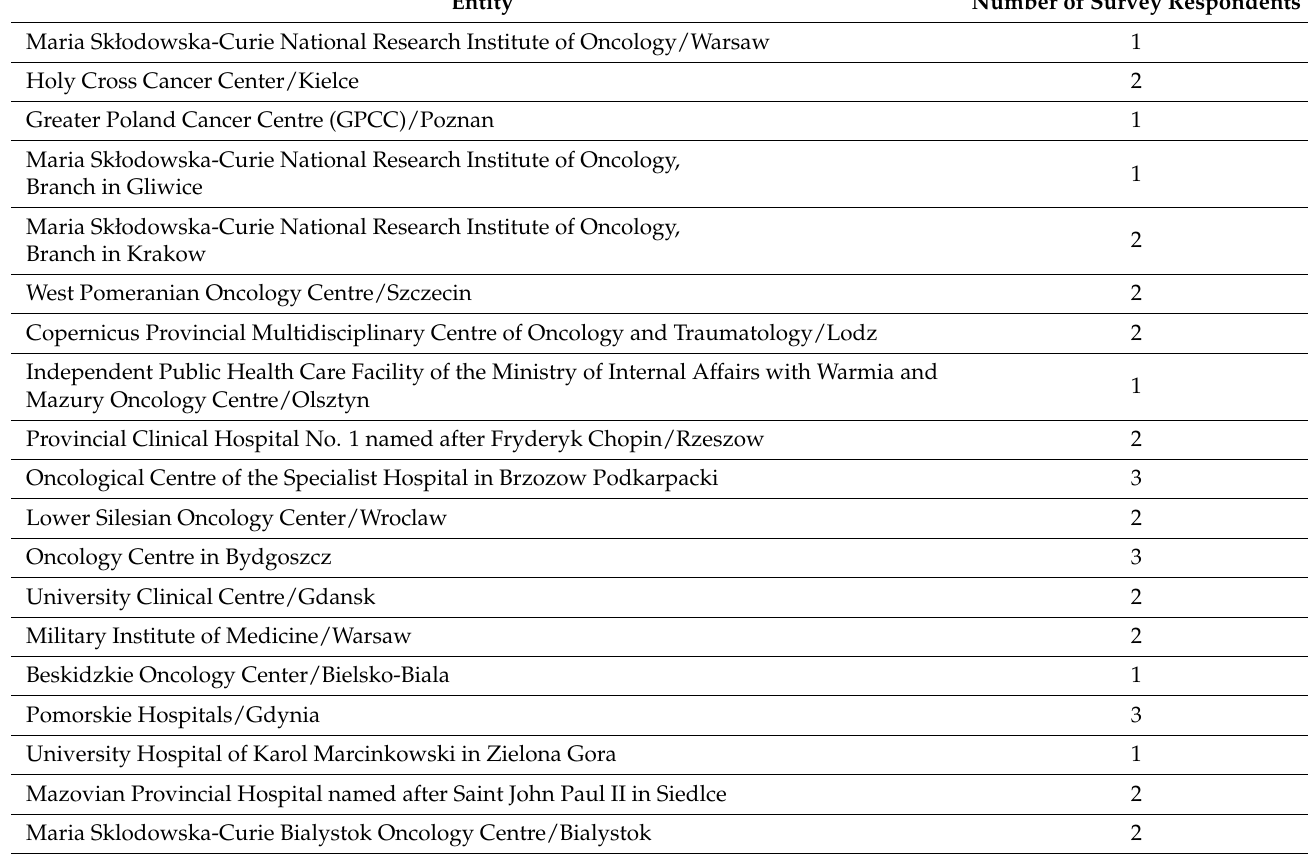
Table 1. Number of survey respondents representing individual units of the National Oncology Network in